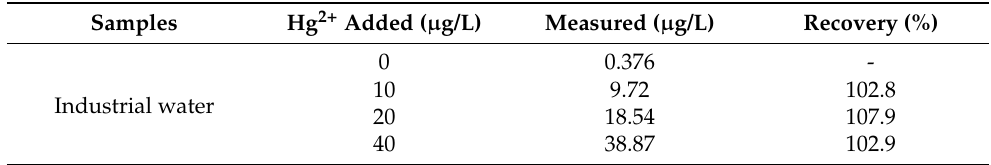
Table 2. Recovery estimation of Hg 2+ in water